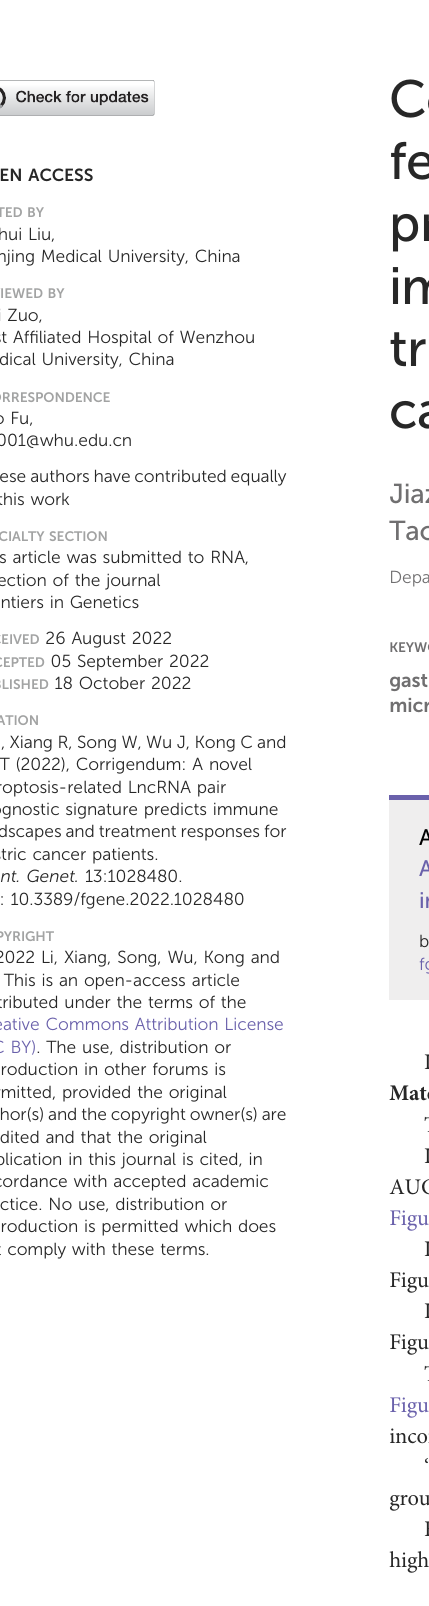
“ Figure 6(B): Expression of 24 immune checkpoint genes in high- and low-risk groups. Figure 6(C): Boxplots showing immune score, stromal score, and ESTIMATE score in high- and low-risk